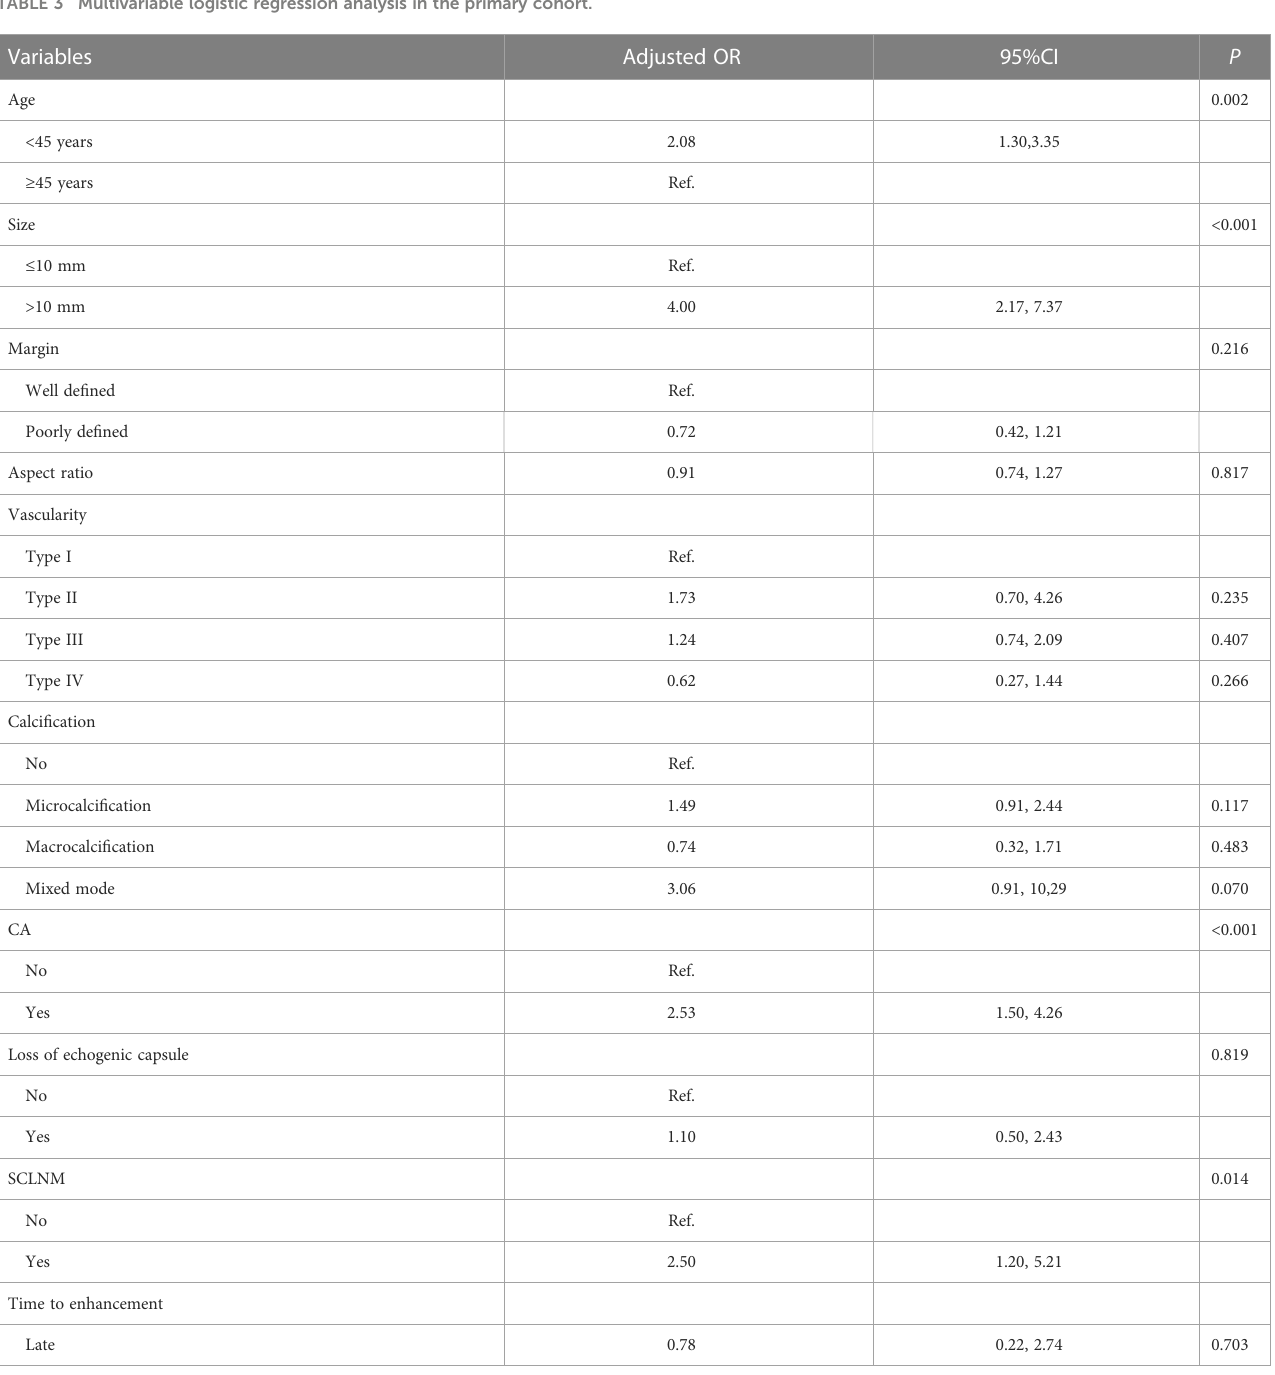
TABLE 3 Multivariable logistic regression analysis in the primary